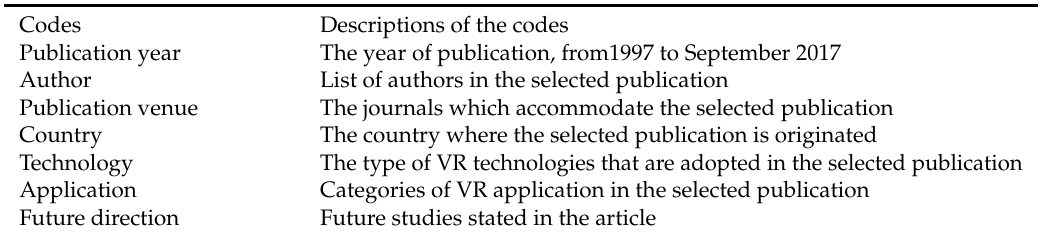
Table 1. Codes that are adopted for content